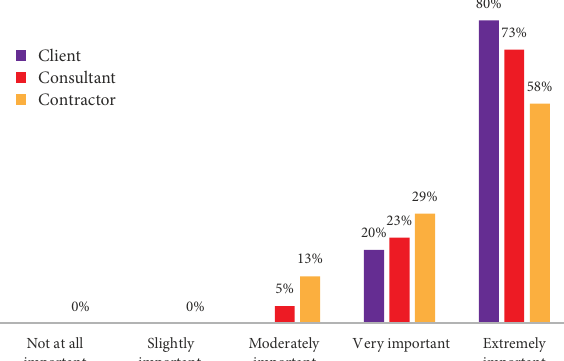
Figure 3. The degree of importance about the